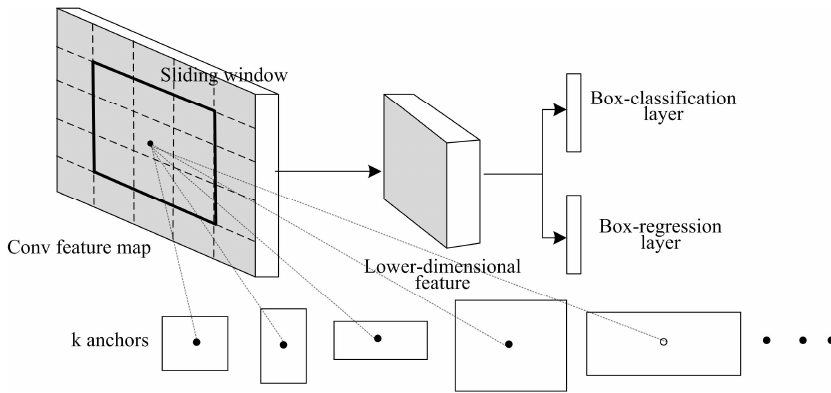
Figure 2. Schematic diagram of region proposal networks (RPNs).